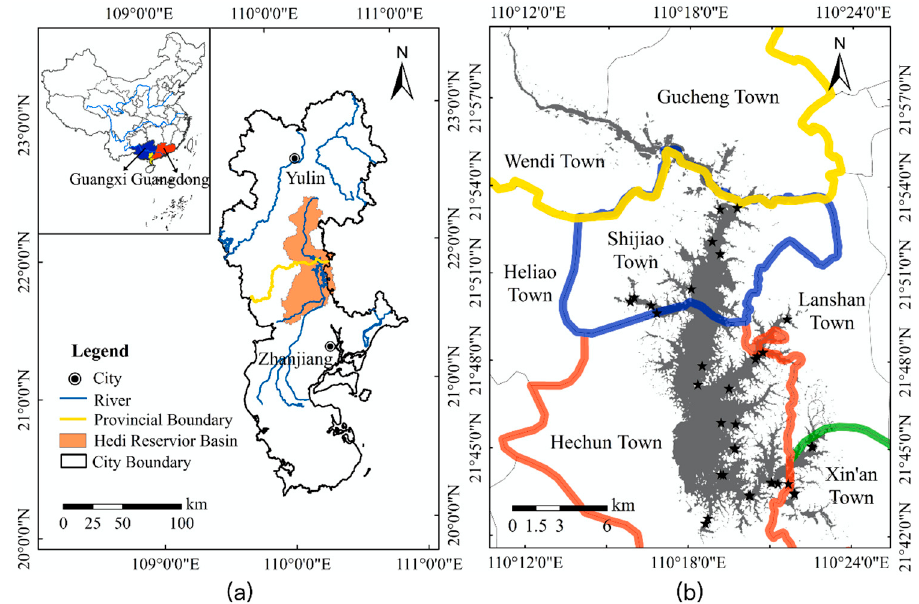
Figure 1. ( a ) Location of the study area (Hedi Reservoir) and the location of the Hedi Reservoir Basin across Zhanjiang, Guangdong Province, and Yulin, Guangxi Province, in China, and ( b ) location of in situ data labeled by black stars and the distribution of sampling stations where different color lines represent different boundaries of towns.